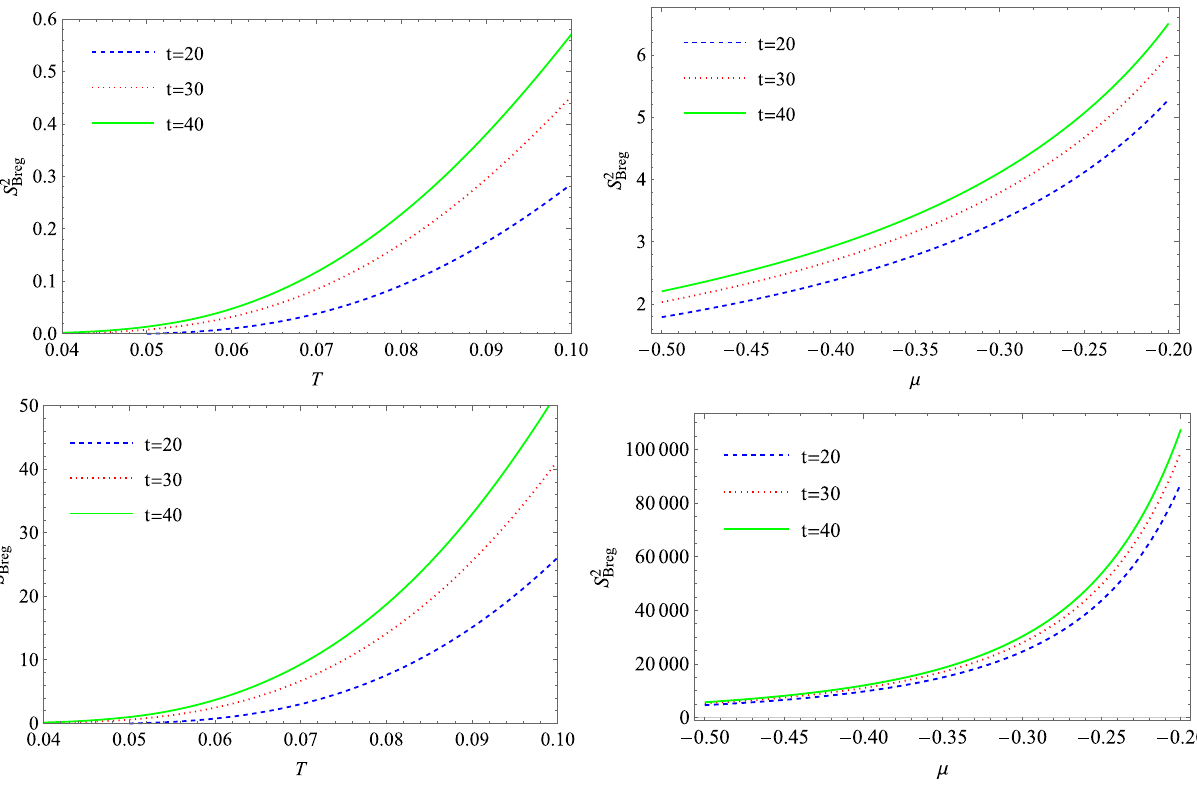
Fig. 4 Bosonic regularized mean square displacement s 2 as a function of the temperature T or the chemical potential μ for the late time Breg approximation, Eq.(68), for some values of the time t . Upper panels: positive fixed value of k . Lower panels: negative fixed value of